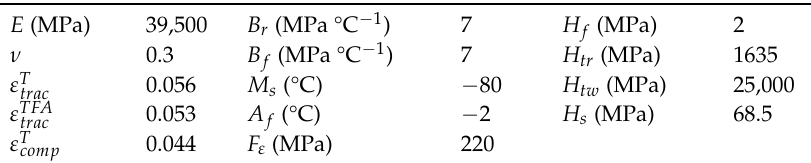
Table 2. Material parameters for